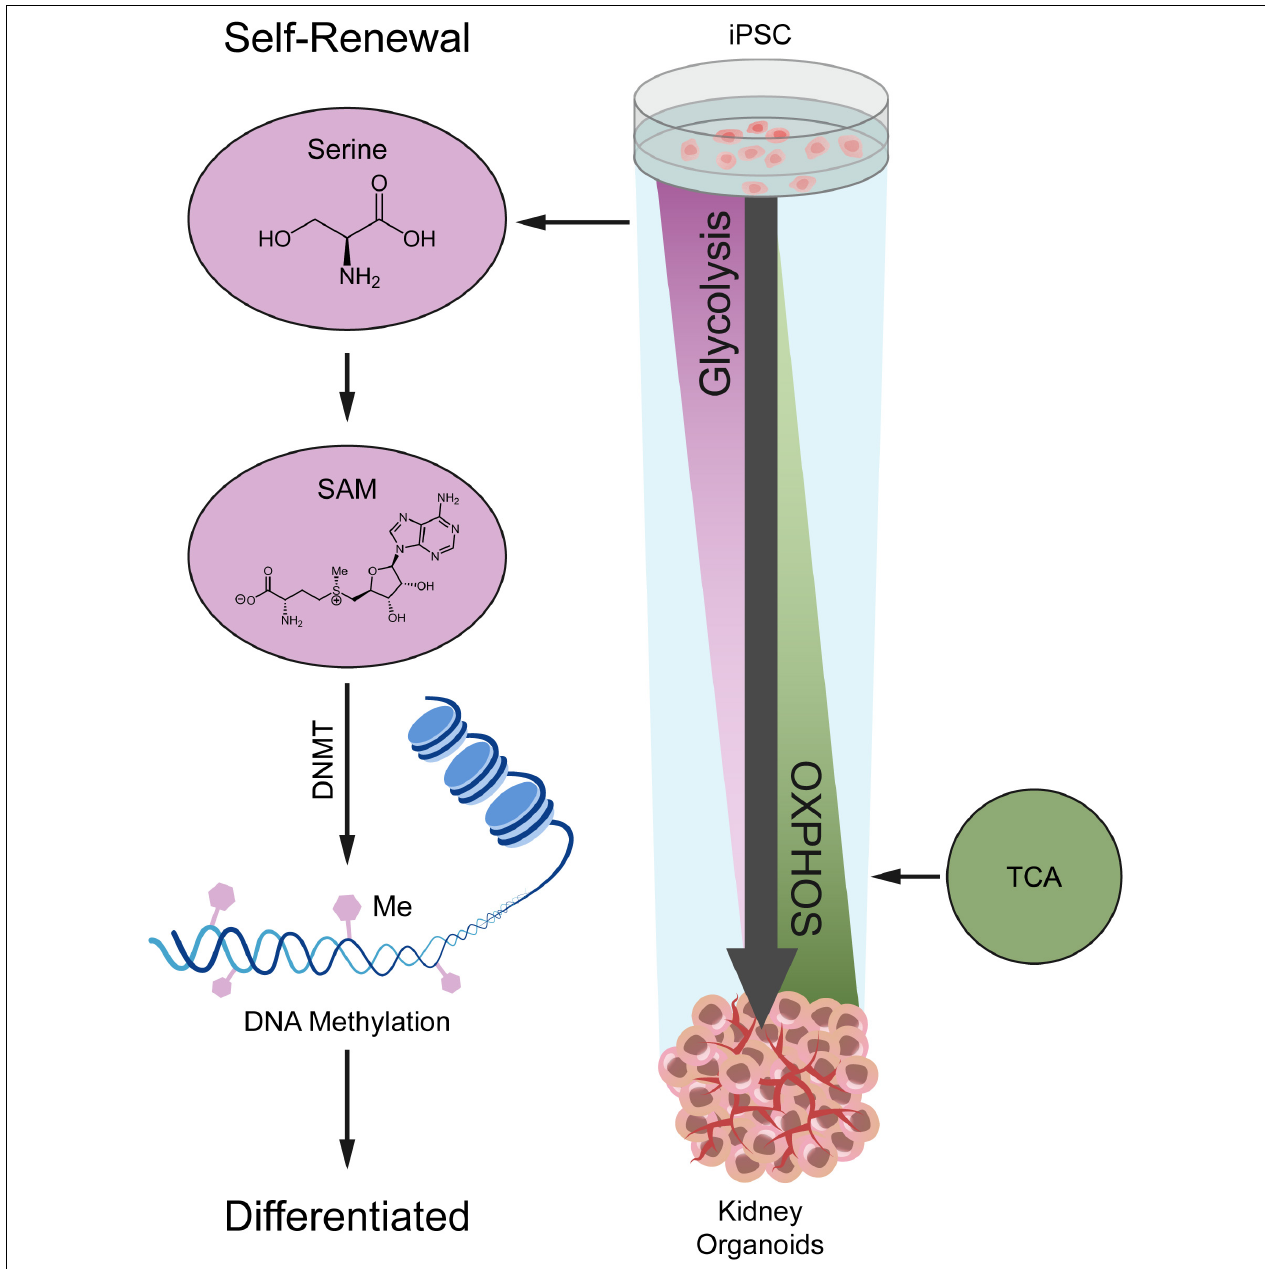
FIGURE 6 | A model depicting the metabolic alteration from glycolysis in iPSC to OXPHOS in kidney organoids.